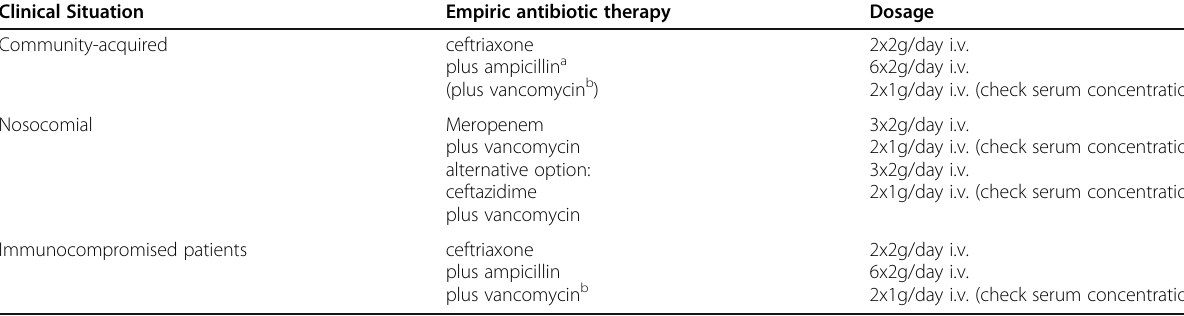
Table 2 Empiric antibiotic therapy in acute bacterial meningitis (according to [3, 4]) Clinical